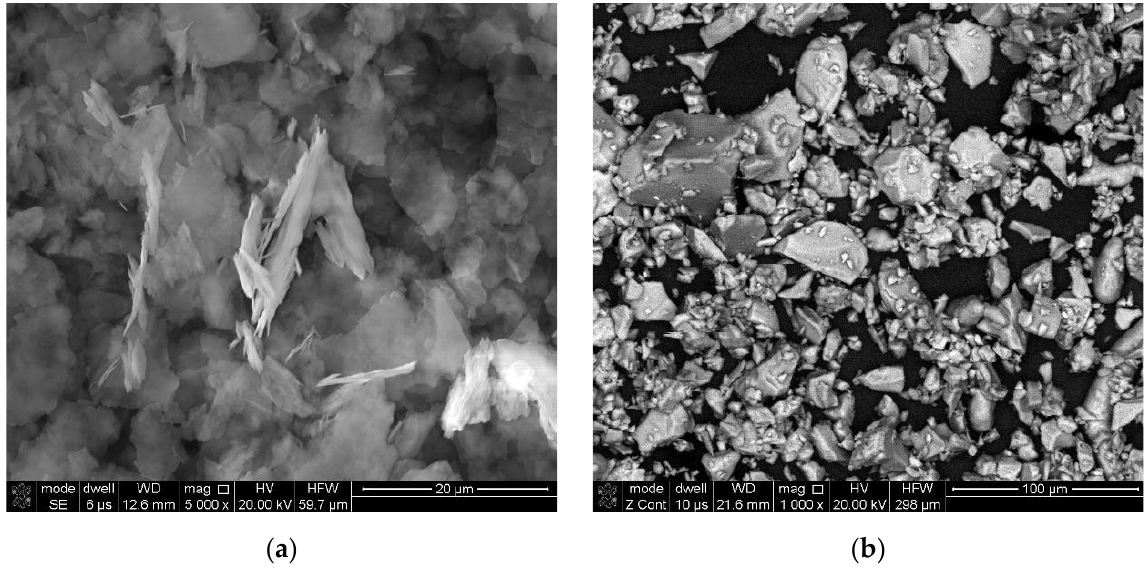
Figure 2. SEM images of the powders: ( a ) Al f ; ( b ) PAM.